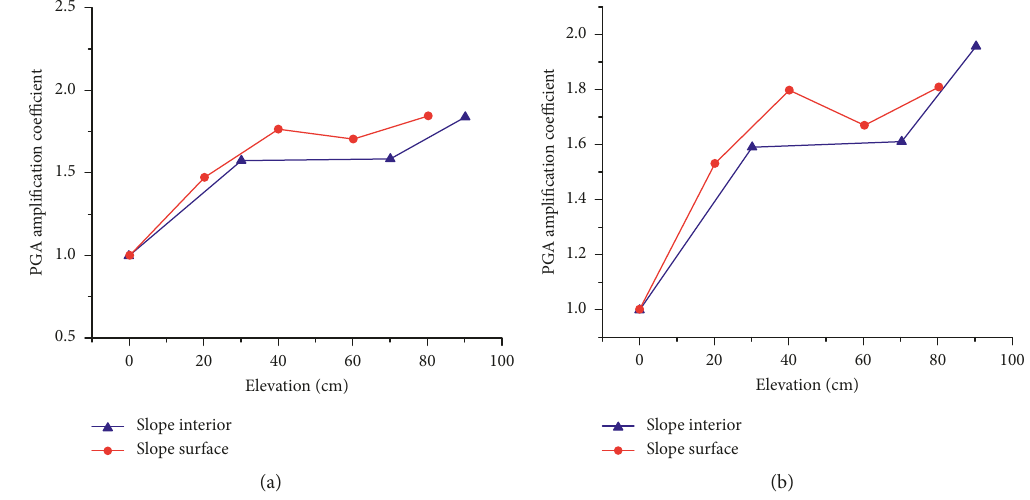
Figure 14: PGA amplification coefficients under condition SIN-1. (a) Convex slope. (b) Concave